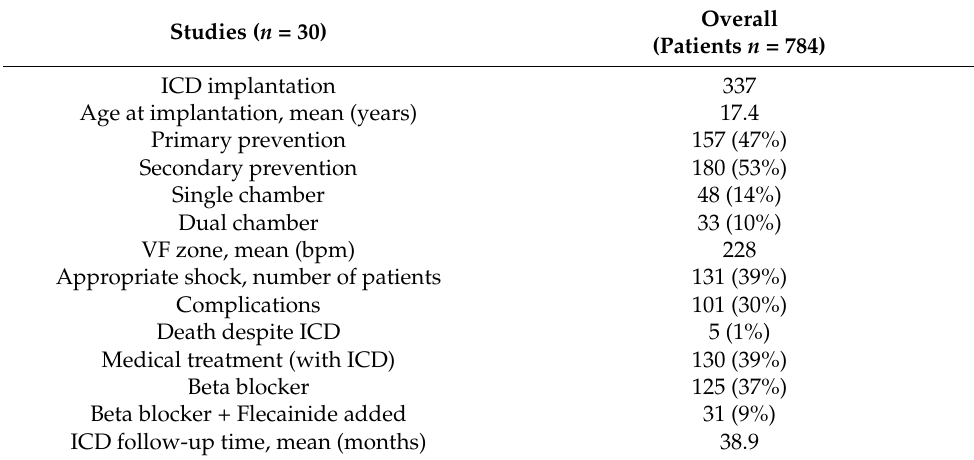
Table 1. Baseline characteristics CPVT patients.